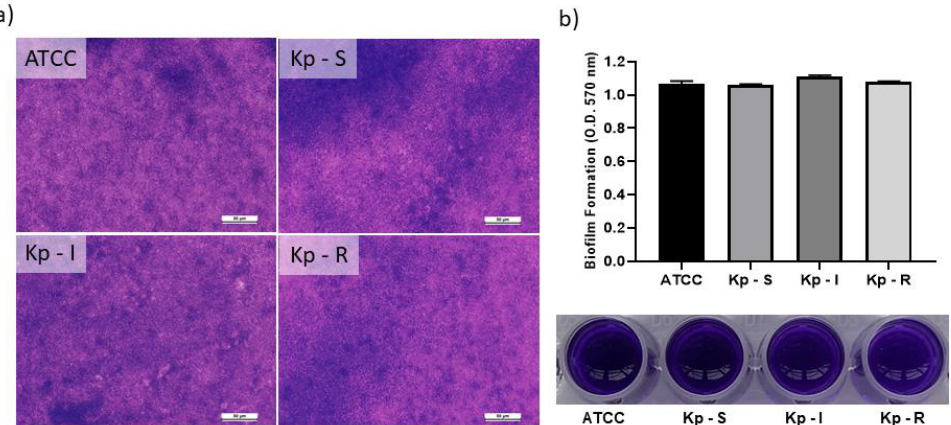
Figure 4. K. pneumoniae biofilm formation: ( a ) The crystal violet assay was used to visualize biofilm formation on polystyrene plates. The scale bars represent 50 μm, and the magnification is ×200; ( b ) graph of the optical density reading (OD 570 ) expressed as mean ± SD of the biofilms with the association of the photograph of the respective wells before the OD measurement.